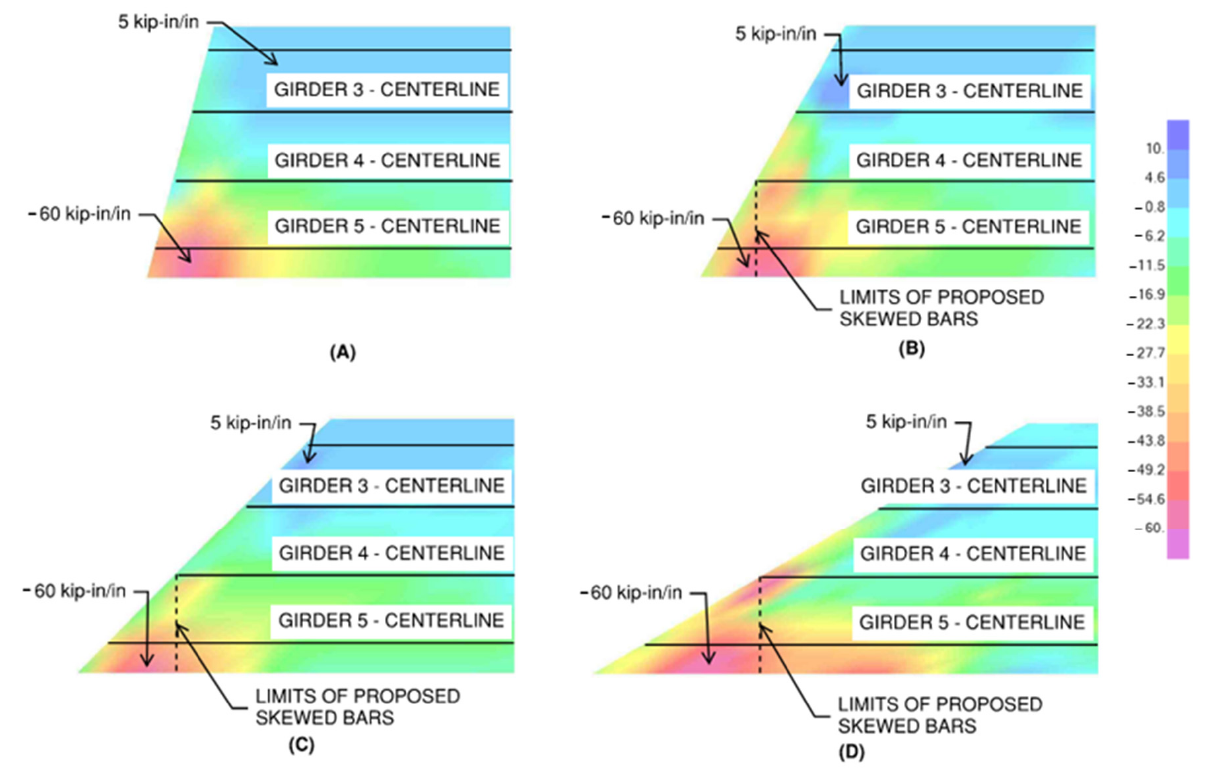
Figure 14. The moment distribution (kip-inch/inch) in the transverse direction for Design Case 1 with ( A ) 15 degree, ( B ) 30 degree, ( C ) 45 degree and, ( D ) 60 degree skews.